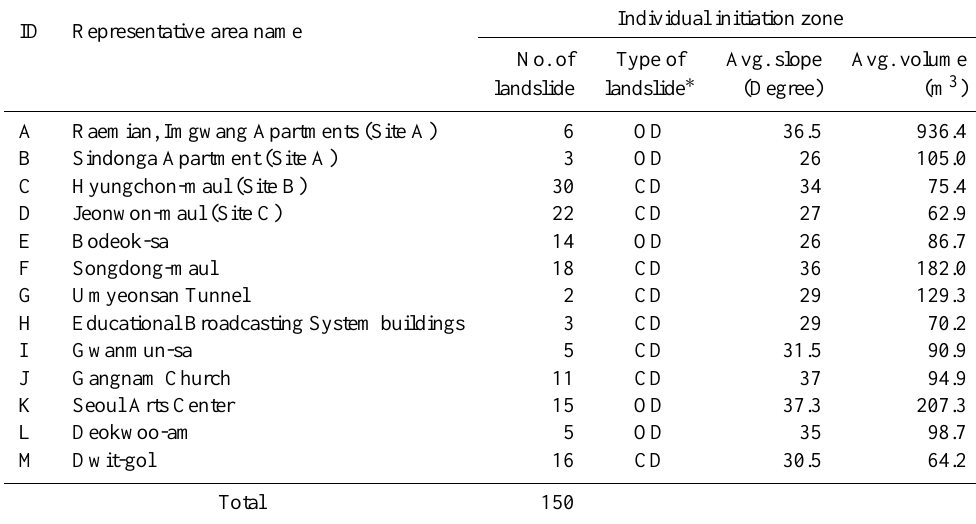
Table 2. Landslides occurred on Mt. Umyeon in 2011. Each landslide area denoted by capital alphabet is also described in Fig. 2. Data are modified from Yoo et al. (2014). Cases being considered in this study (Sites A to C) are indicated in the column of the representative area